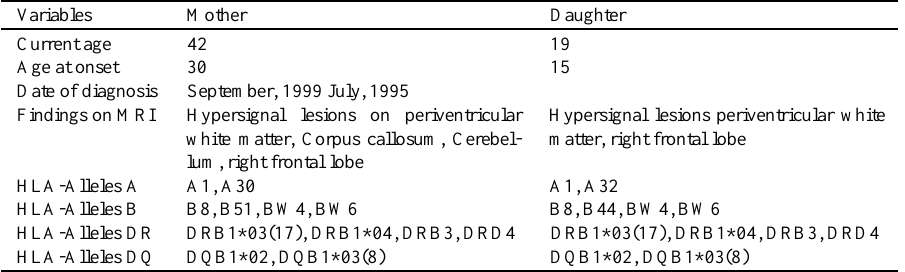
Fig. 1. T2-weighted gadolinium-enhanced MRI showing hyperintense lesions in the corpus callosum, cerebellum, periventricular white matter, and right frontal lobe. The presence of oedema in the frontal lesion suggest that it is active. Table 1 Age, MRI findings, and HLA